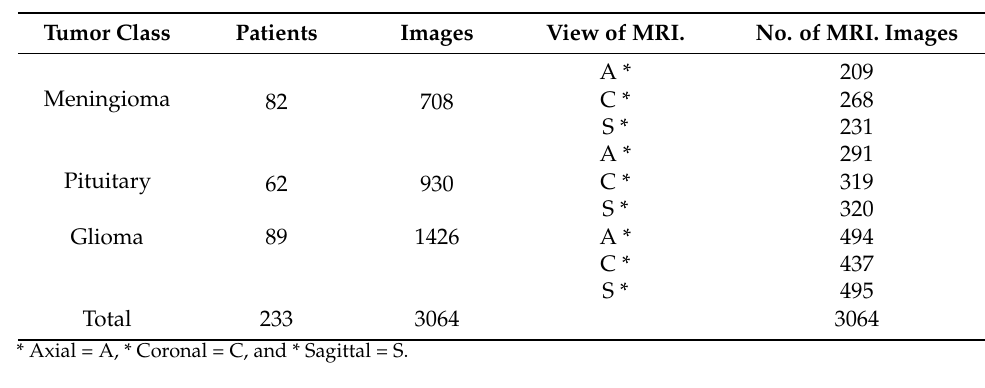
Table 1. Explanation of CE-MRI dataset.